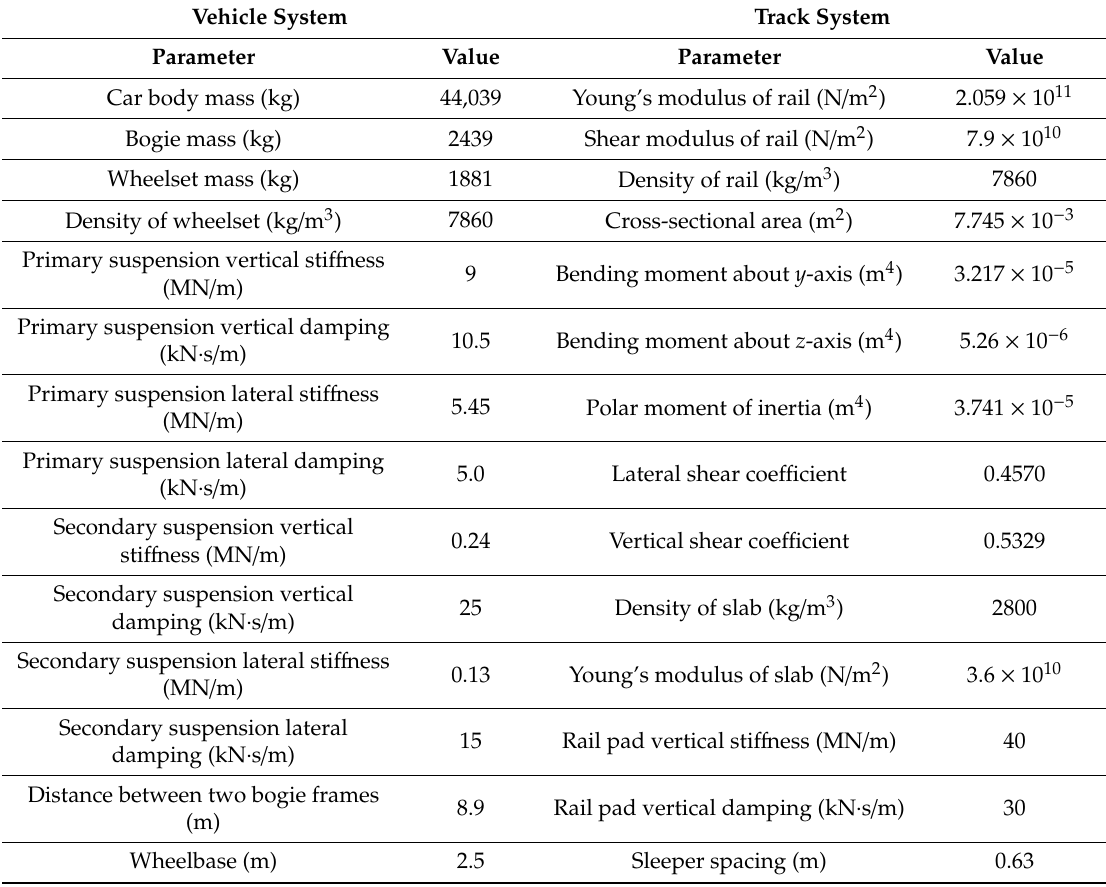
Figure 7. Vehicle–track rigid–flexible coupling dynamical model. Figure 7. Vehicle – track rigid – flexible coupling dynamical model. Table 1. Parameter values of the vehicle and track